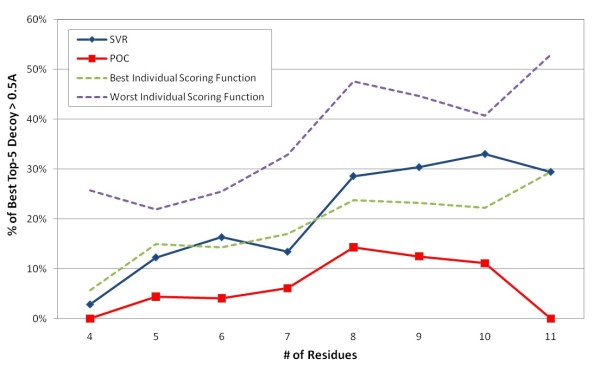
Selection performance comparison between POC and SVR in identifying the top-5 decoys in Jacobson's decoy sets